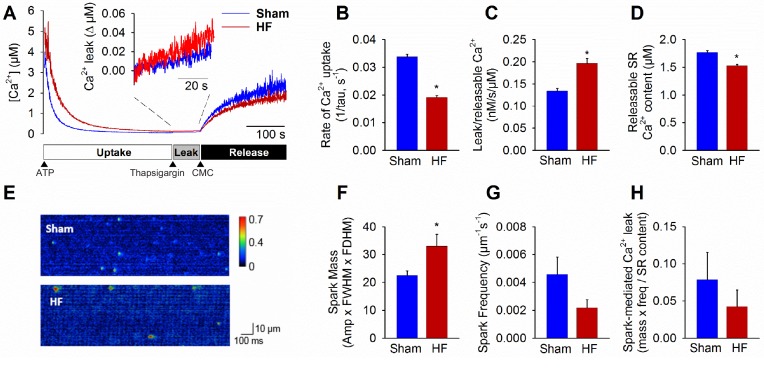
Failing cardiomyocytes exhibit increased ‘silent’ RyR leak.Total RyR-mediated Ca2+ leak was assessed in SR microsomes using fura-2 fluorescence (A). Vesicular Ca2+ uptake was initiated by addition of ATP, and halted by addition of thapsigargin. SR Ca2+ leak was estimated as the thapsigargin-induced rate of rise of [Ca2+], normalized to releasable SR content (rise in [Ca2+] induced by the RyR opener 4-chloro-m-cresol, CMC). While the rate of SR Ca2+ uptake was reduced in HF relative to Sham (B), total RyR leak was increased (C) even with a slight reduction in the releasable Ca2+ store (D). (n = 8 from 3 Sham hearts, 7 from 3 HF hearts; *=P < 0.05 vs Sham). To assess whether elevated SR leak in failing cells could be attributed to Ca2+ sparks, line-scan confocal imaging of resting cardiomyocytes was employed (E). Ca2+ spark mass was increased in HF relative to Sham (F), due to augmented spark geometry (Figure 5B). However, since spark frequency tended to be reduced (G), overall Ca2+ spark-mediated leak was similar in Sham and HF (H). These results are consistent with increased ‘silent’ non-spark-mediated SR leak in HF cardiomyocytes. (FWHM = full width at half maximum, FDHM = full duration at half maximum; ncells = 43 in Sham, 50 in HF; *=P < 0.05 vs Sham).